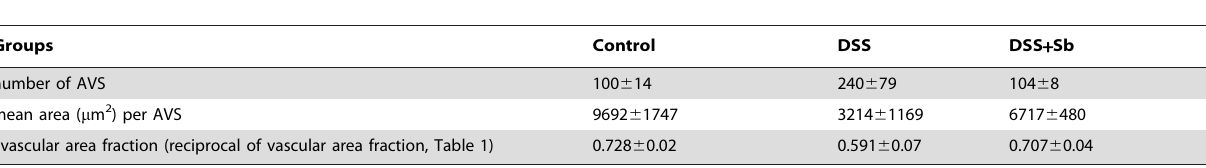
Table 2. Avascular spaces (AVS) results (mean 6 std